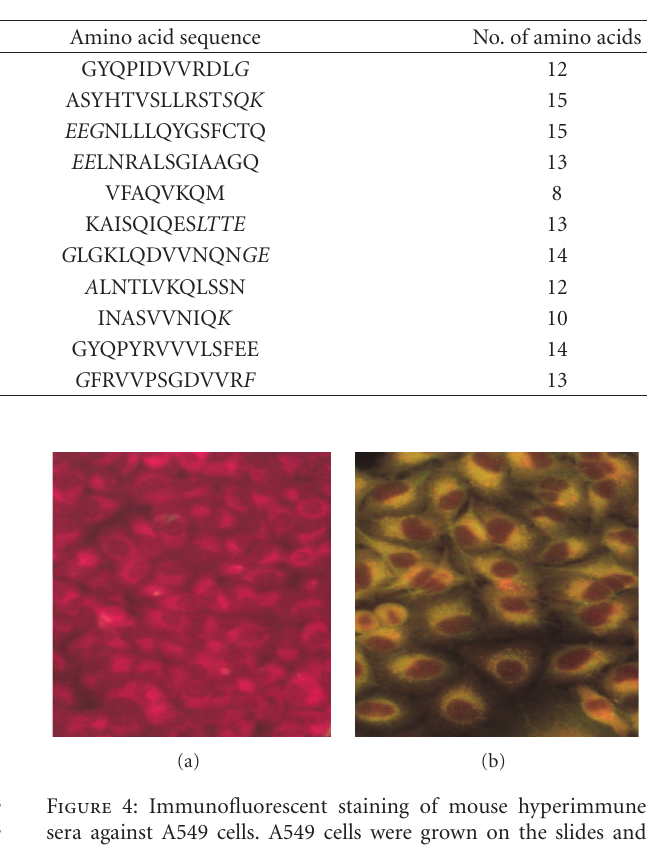
Table 1: Amino acid sequence of the eleven synthetic peptides ∗ Extra amino acid residues which were indicated by italic letters were added at either N- or C-terminus to decrease the hydrophobicity.